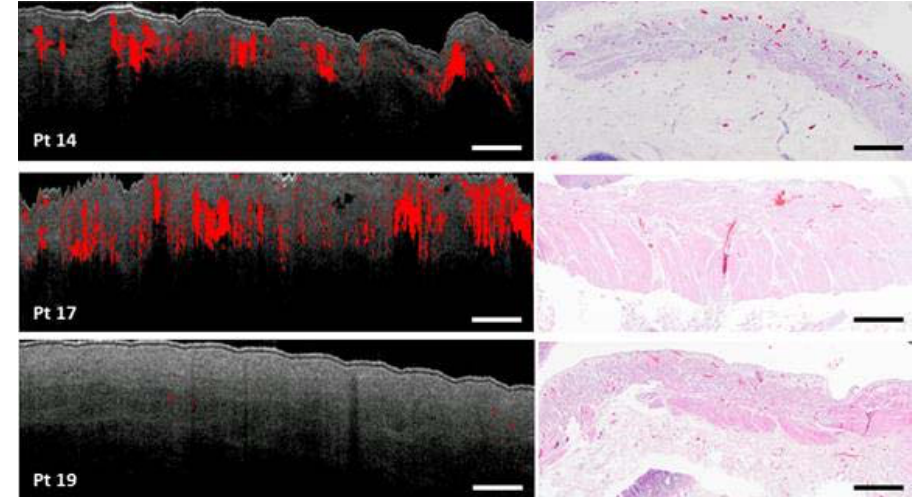
Figure 10. OCT scan of location 4 (fundus), the scale bar depicts a length of 1 mm, and histology slides HE-stained, of patient 14, 17 and 19 with blood vessels in red and tissue layers: serosa, subserosa (purple/dark pink), muscularis propria (light pink).